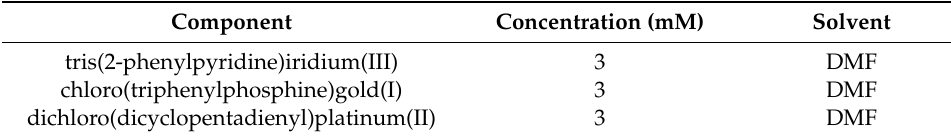
Table 1. The compositions of solutions used for LCLD experiments. Component Concentration